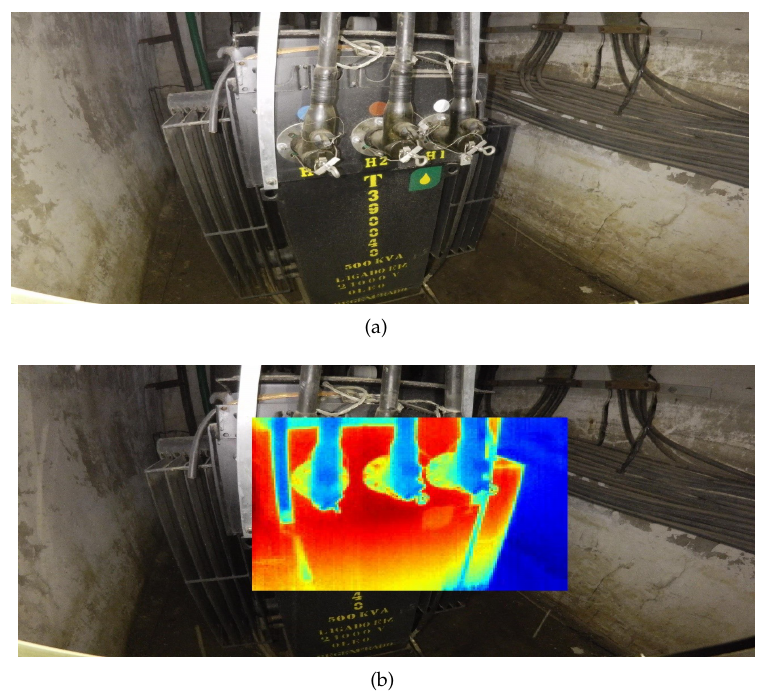
Figure 15. Outputs of using drones on underground vaults. ( a ) digital Images from drones; ( b ) ther- mal images from drones.